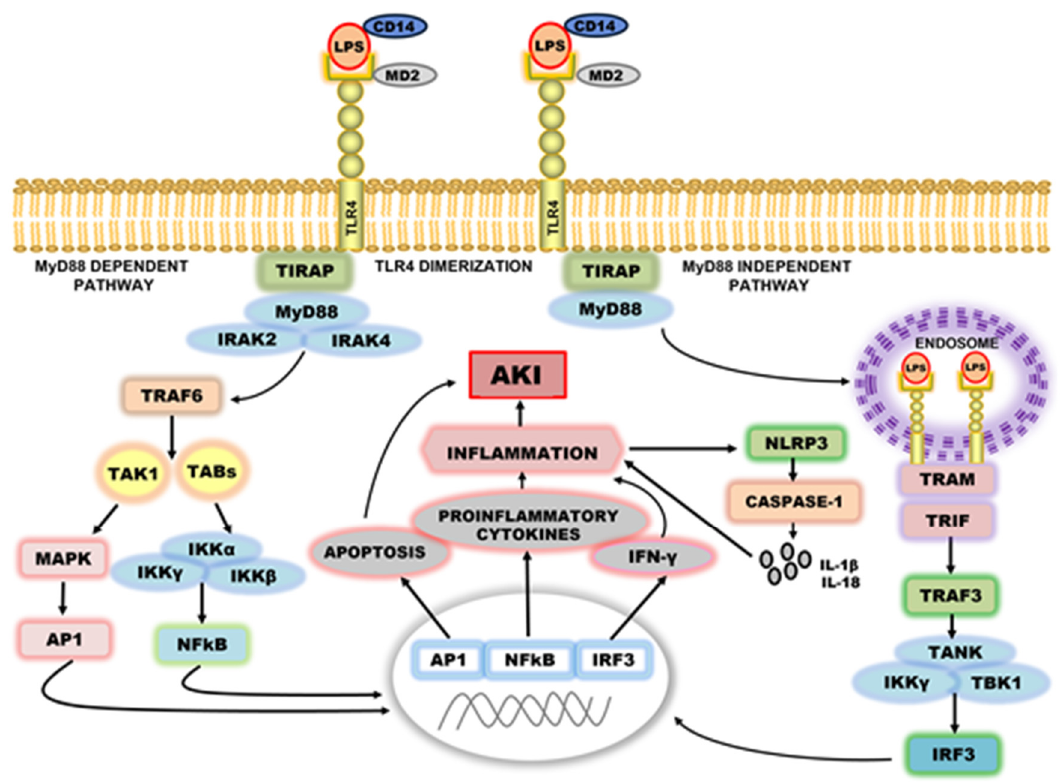
Figure 1. TLR4 signaling pathway. Abbreviations : AKI, acute kidney injury; AP-1, activating pro- tein-1; CD14, cluster of differentiation 14; IFN- γ , interferon gamma; IKK, inhibitor of Kappa B kinase; IRAKs, interleukin-1 receptor associated kinase; IRF-3, interferon regulatory factor 3; LBP, lipopolysaccharides-binding protein; LPS, lipopolysaccharides; MAPKs, mitogen-activated protein kinase; MD2, myeloid differentiation factor 2; MyD88, myeloid differentiation primary response 88; NF- κ B, nuclear factor kappa B; NLRP3, NLR family pyrin domain containing 3; TABs, TAK1-binding proteins; TANK, TRAF associated NF- κ B activator; TBK1, TANK binding Kinase-1; TRAM, TRIF-related adaptor molecule; TIRA, TIR-domain containing adaptor protein; TLR4, toll-like receptor-4; TNF- α , tumor necrosis factor alpha; TRIF, TIR-domain-containing adaptor-inducing interferon- β .